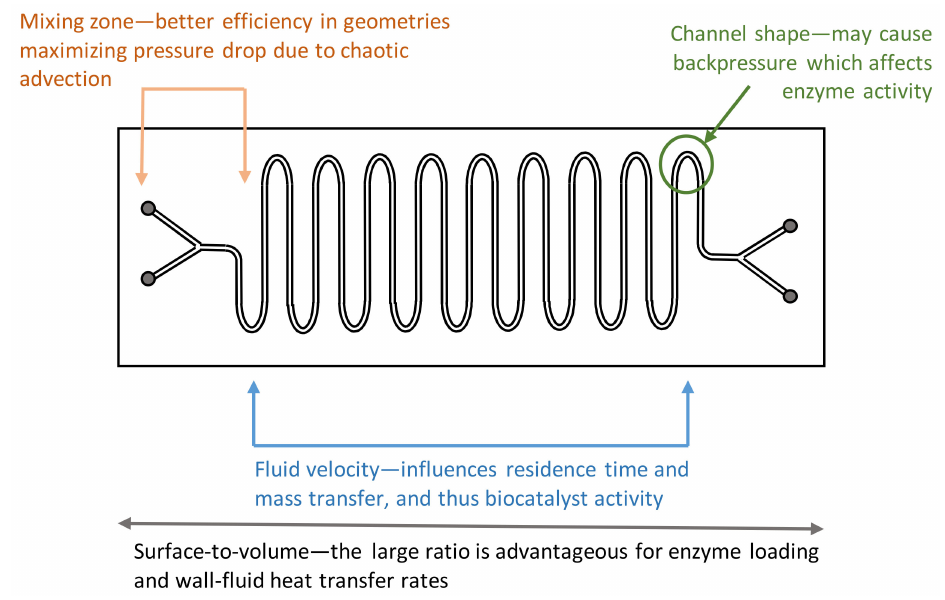
Figure 4. Critical aspects in microreactors, such as the mixing zone, the shape of the channel and fluid velocity, may be engineered to improve mass and heat transfer, and thus biocatalyst